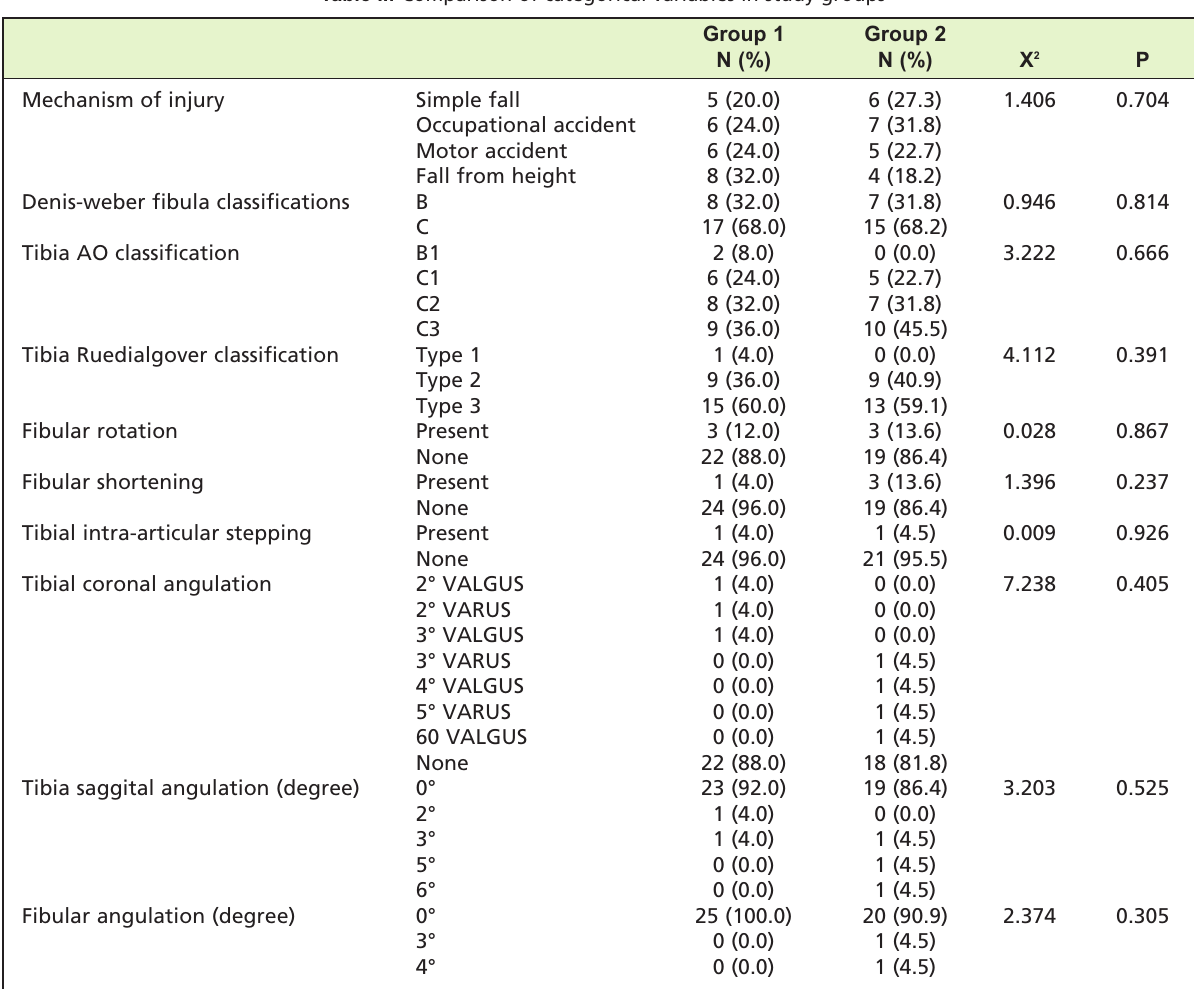
Comparison of categorical variables in study Table II: